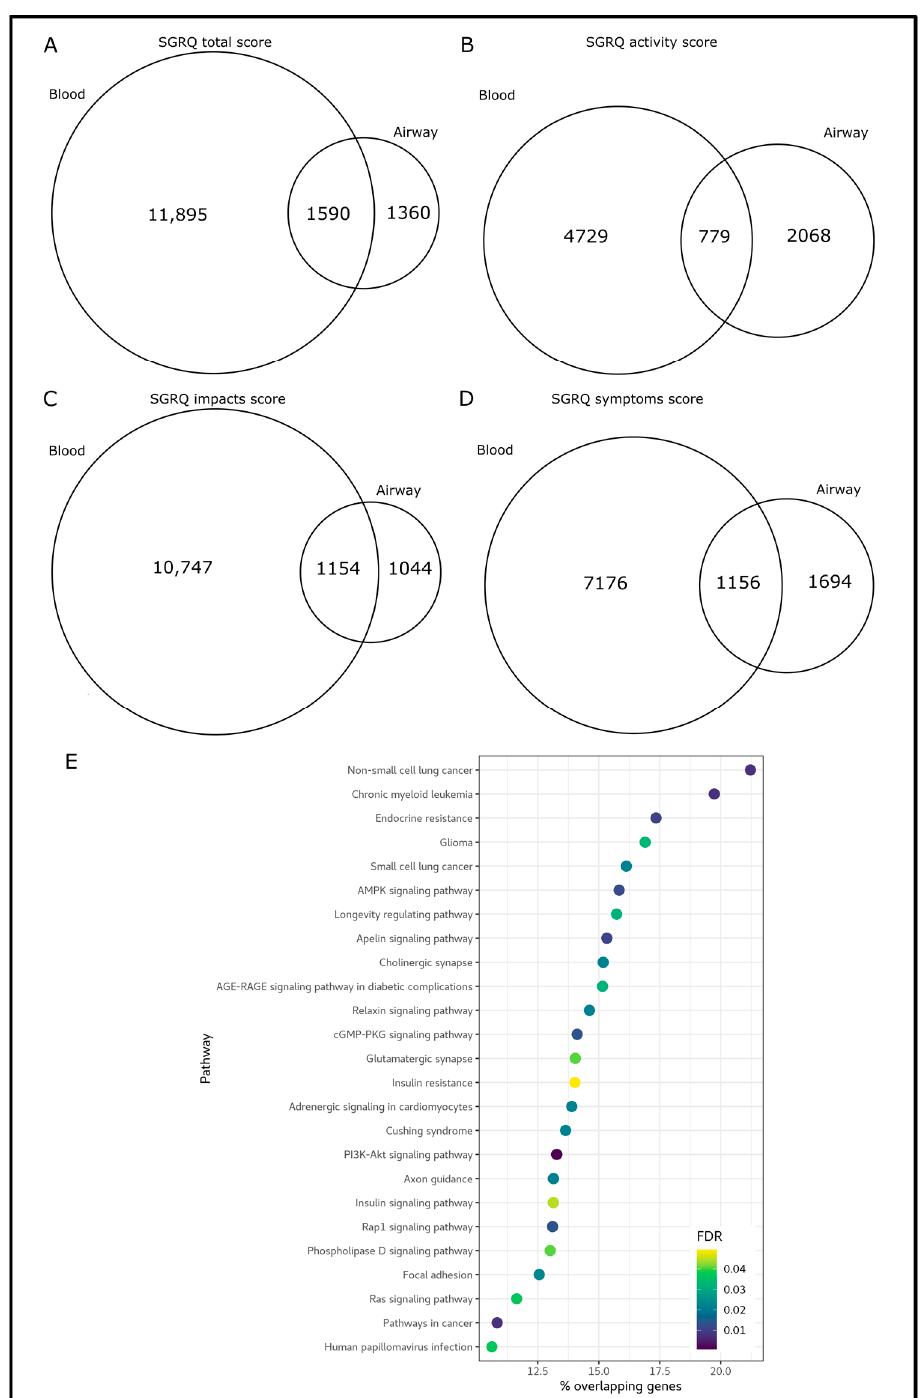
Figure 3. Differentially methylated genes overlapped between tissues. Venn diagrams show the overlap of differentially methylated genes identified in blood versus those in the airway for the total SGRQ score ( A ), and its domains: activity ( B ), impact ( C ) and symptom ( D ) scores. ( E ) shows the pathways enriched by the differentially methylated genes identified in blood and airway tissue.